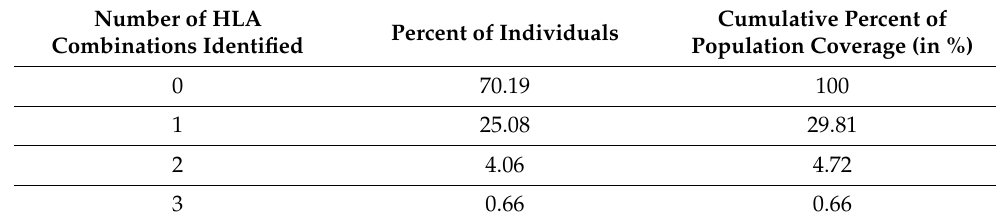
Table 6. India Asian-class II coverage.